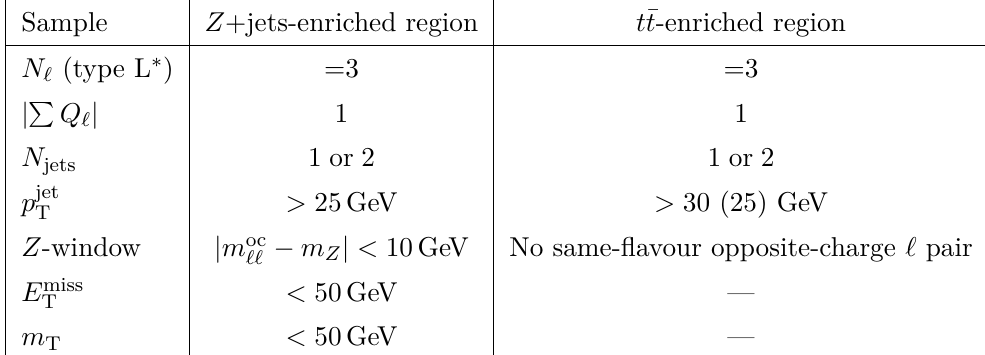
— — , is calculated as the invariant T